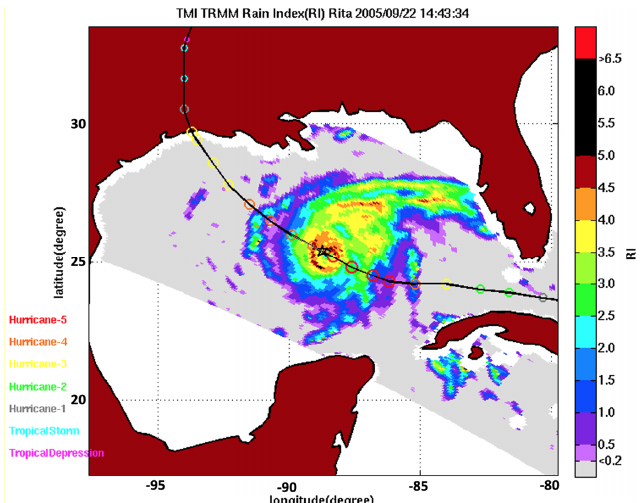
Figure 2. Hurricane Rita as observed by Tropical Rainfall Measuring Mission (TRMM) on 22 September 2005 at 14:43Z. The storm structure is depicted by the Rain Index–a multichannel non-linear combination of the passive microwave brightness temperatures observed by TMI. The data are available from the TC Data Archive [49].